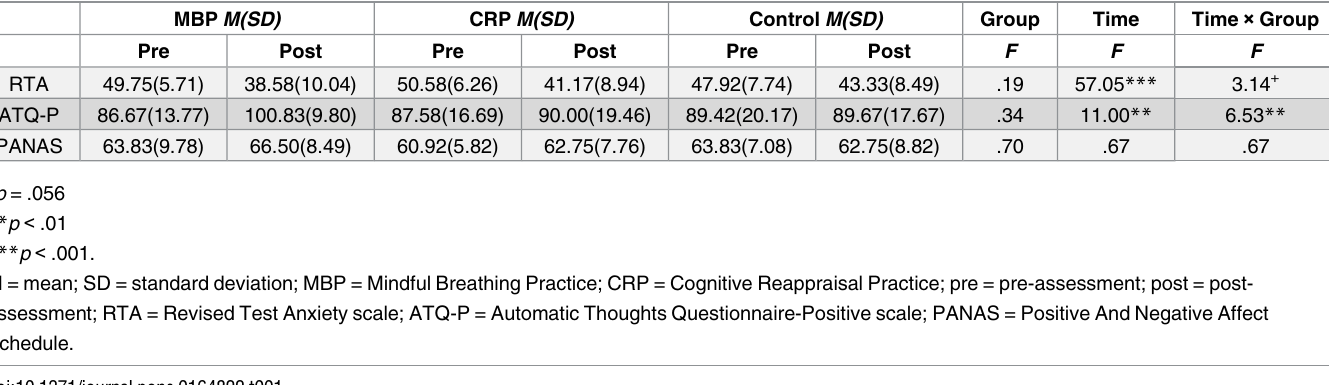
Table 1. Test anxiety, positive thoughts and affect mean scores pre- and post-group treatment. MBP M(SD) CRP